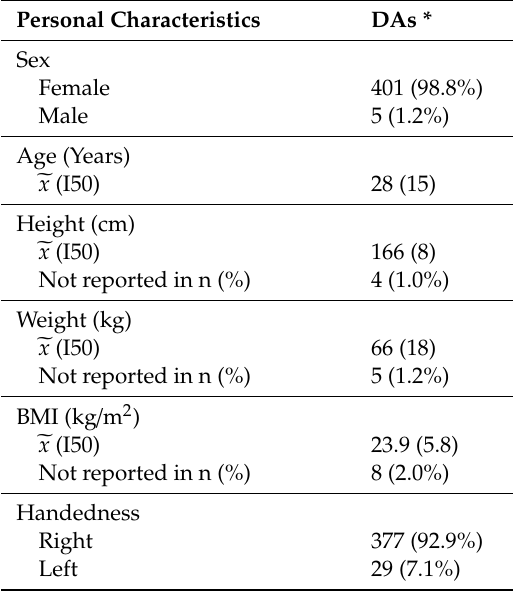
Table 1. Personal characteristics data of the study population. In addition to the number (n) of participants, the interquartile distance (I50) was also shown, if